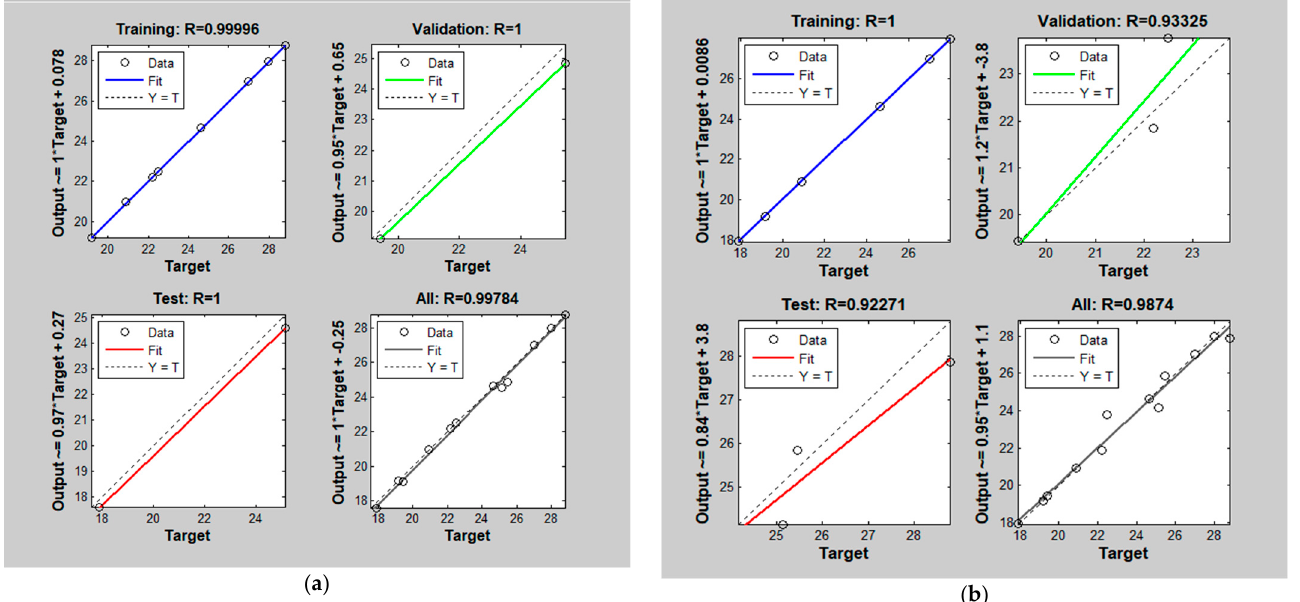
Figure 18. The Pearson’s correlation coefficient R and the mean squared error (MSE) of the experi- mental and predicted ( a ) CS for PC, WOC, and WOC-Hybrid concrete ( b ) TS for PC, WOC, and WOC-Hybrid concrete.